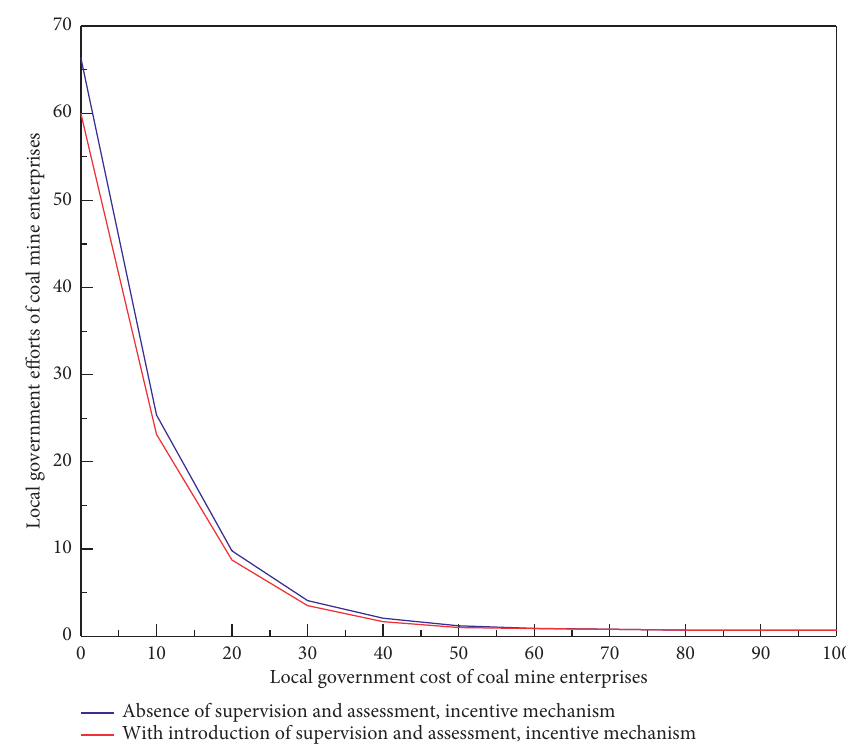
Figure 3: Relationships between emergency response efforts and emergency response costs of the local government in two